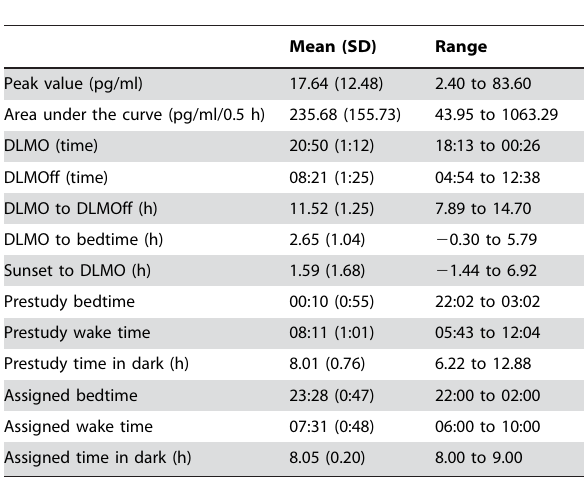
Table 3. Melatonin profile characteristics and sleep